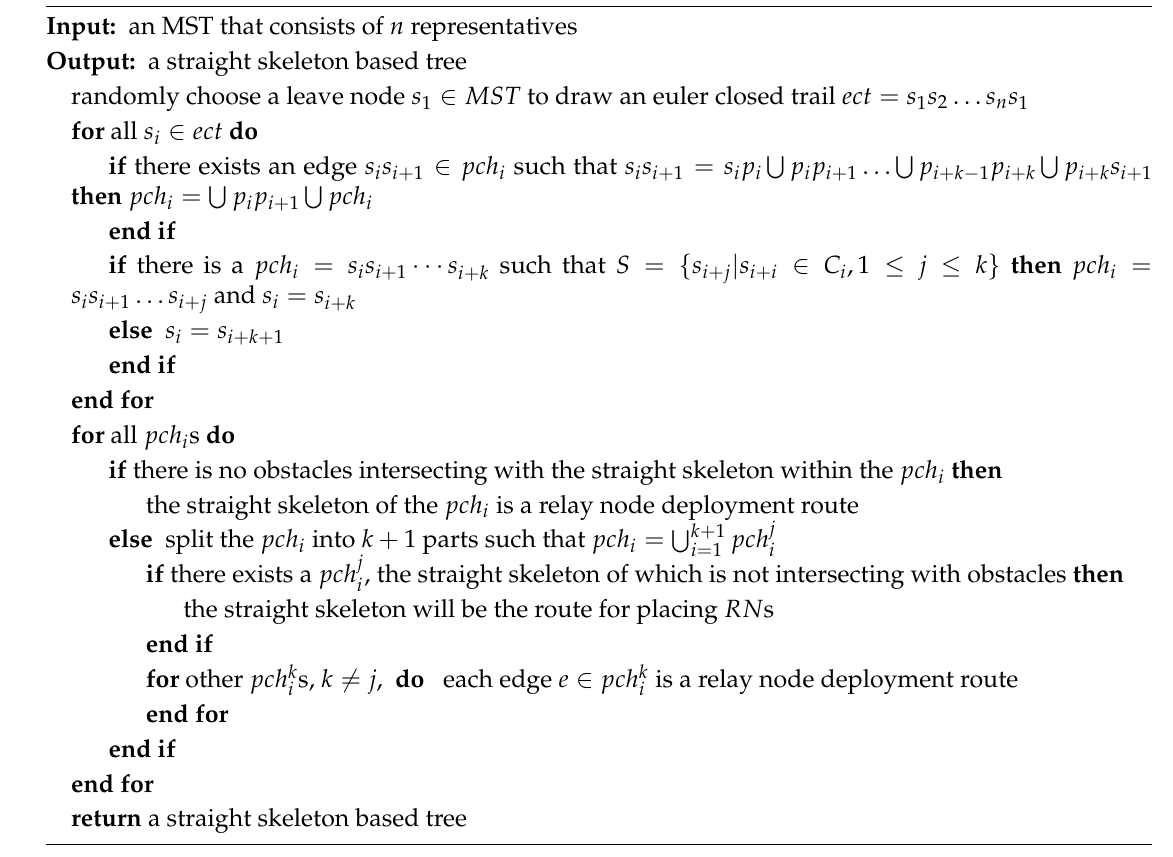
Algorithm 3 Straight Skeleton based SMT Construction Algorithm